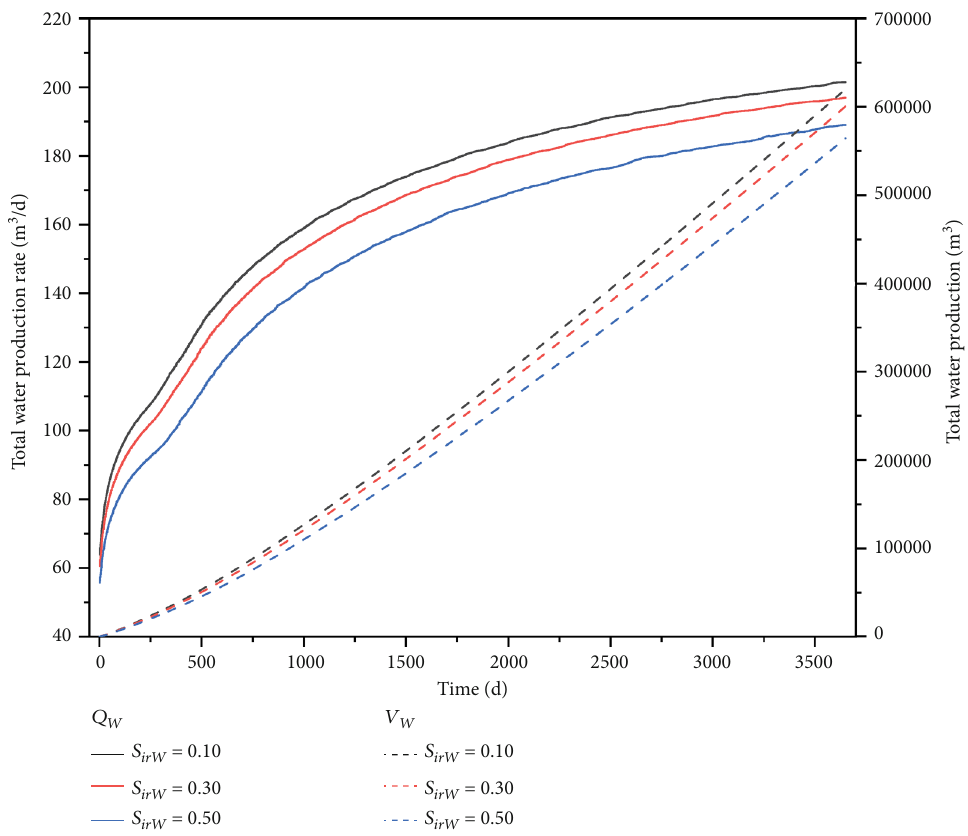
Figure 9: Evolution of total water production rate Q